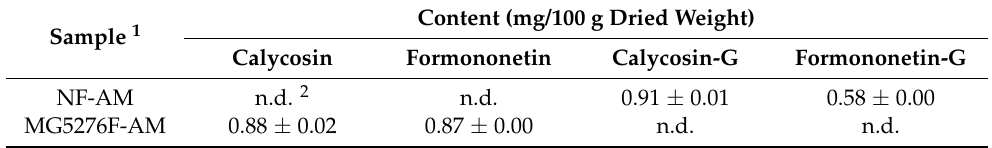
Table 3. Contents of isoflavonoids aglycones and its glycosides in NF-AM and MG5276F-AM ( n = 3). Sample